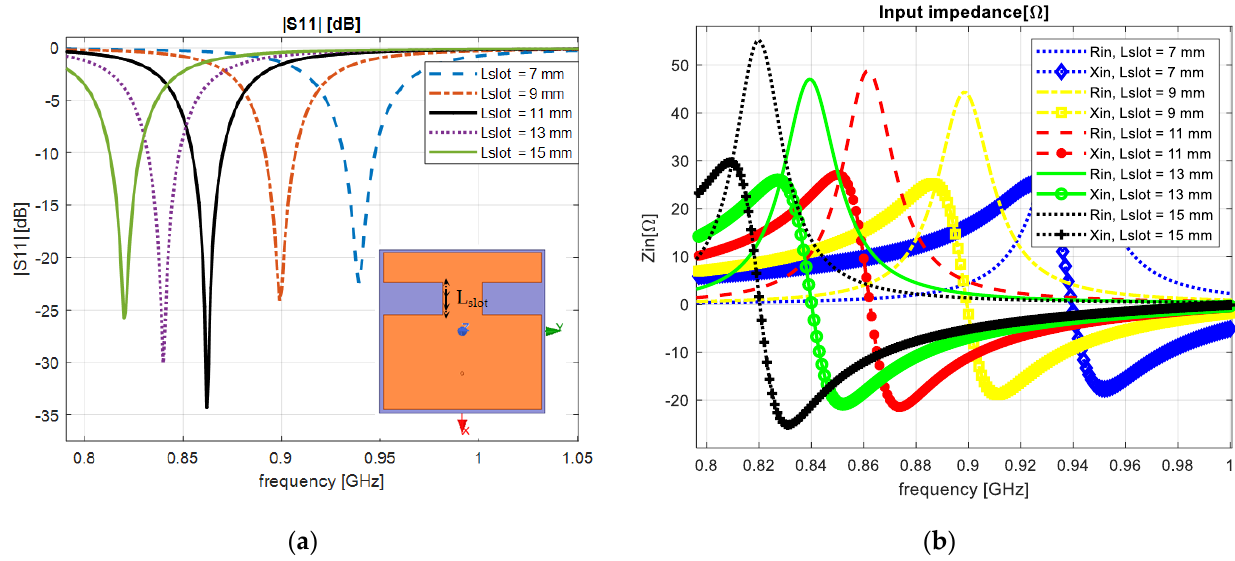
Figure 4. Varying the notches ’ length: ( a ) reflection coefficient; ( b ) input impedance.